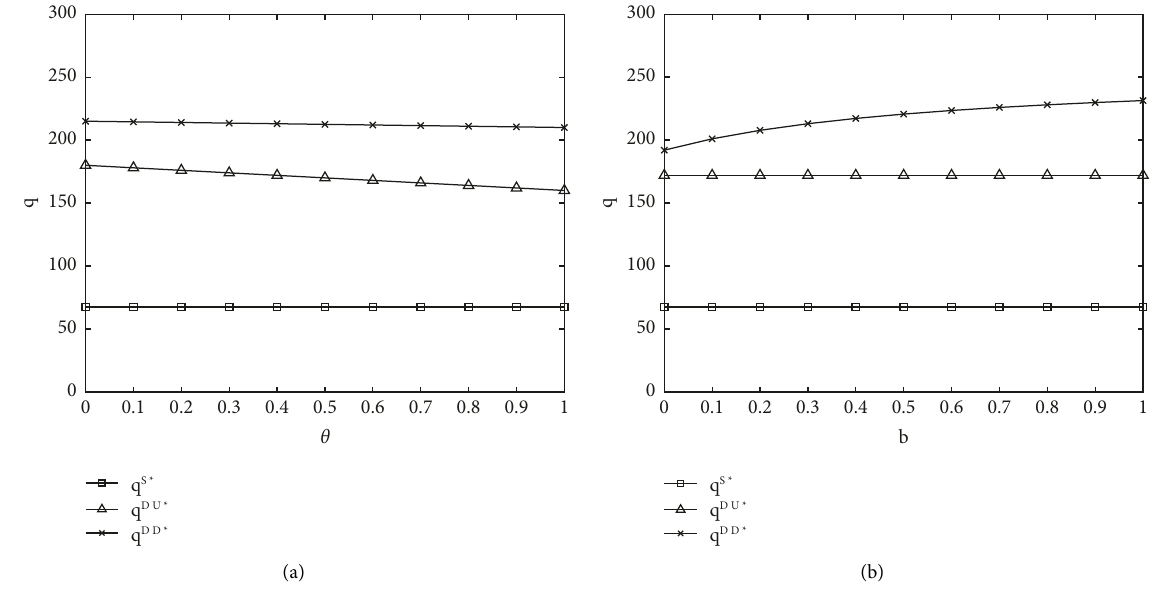
Figure 7: Comparison of optimal recycling volumes among three models: (a) b � 0 . 3; (b) θ � 0 .